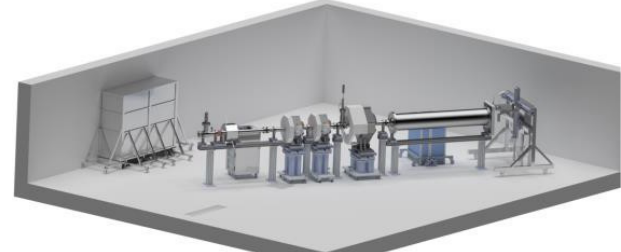
Fig. 3. Final design of METU-DBL. The beamline starts at the exit of the 5- port magnet. A large custom-design quadrupole magnet follows two smaller ones. The beam pipe gets wider as the beam blows up towards the end of the beamline. 5-port switching magnet and radiation shields are not